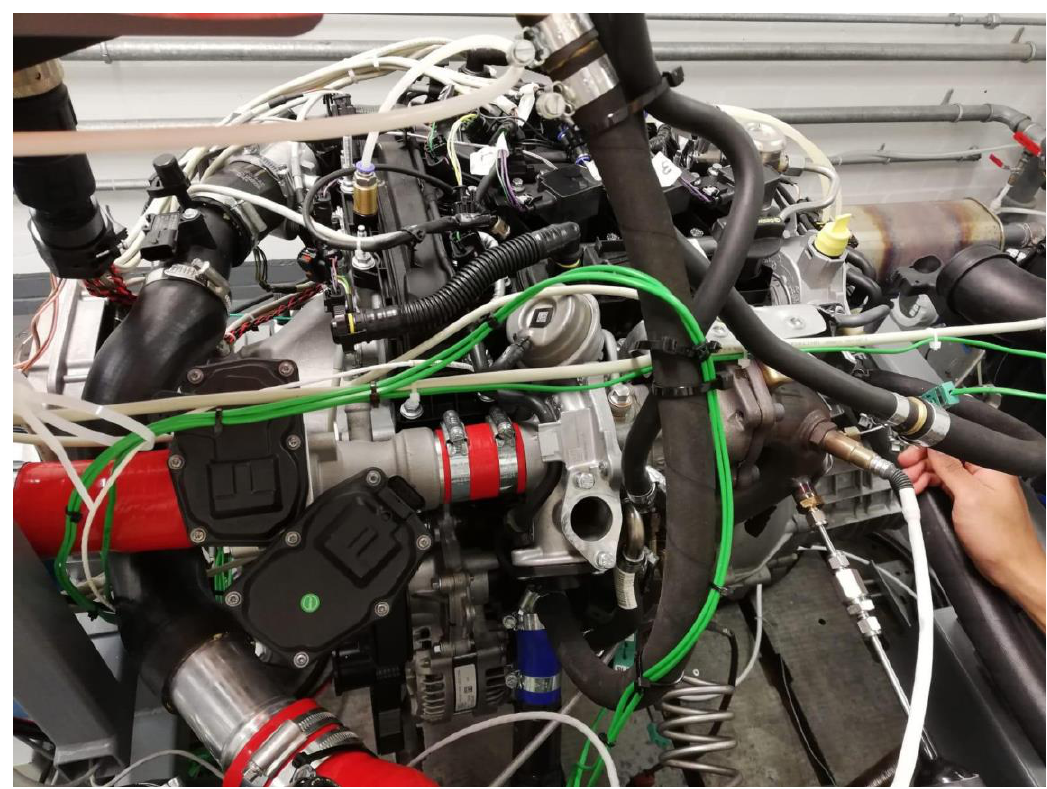
Figure 3. Engine on the dyno before testing.